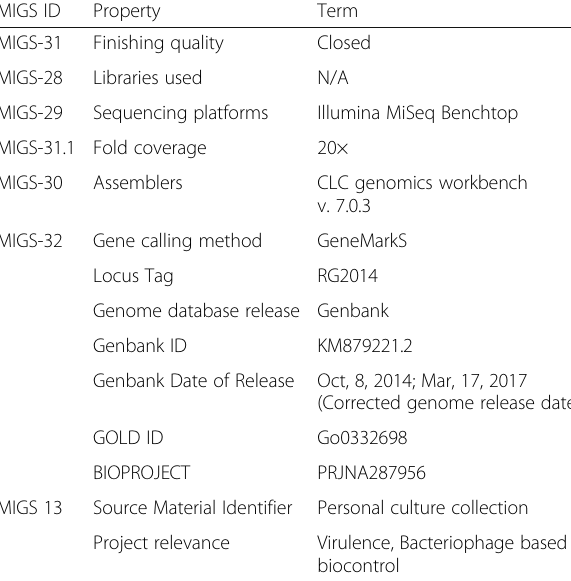
Table 2 Project information of Delftia tsuruhatensis ARB-1 bacteriophage RG-2014